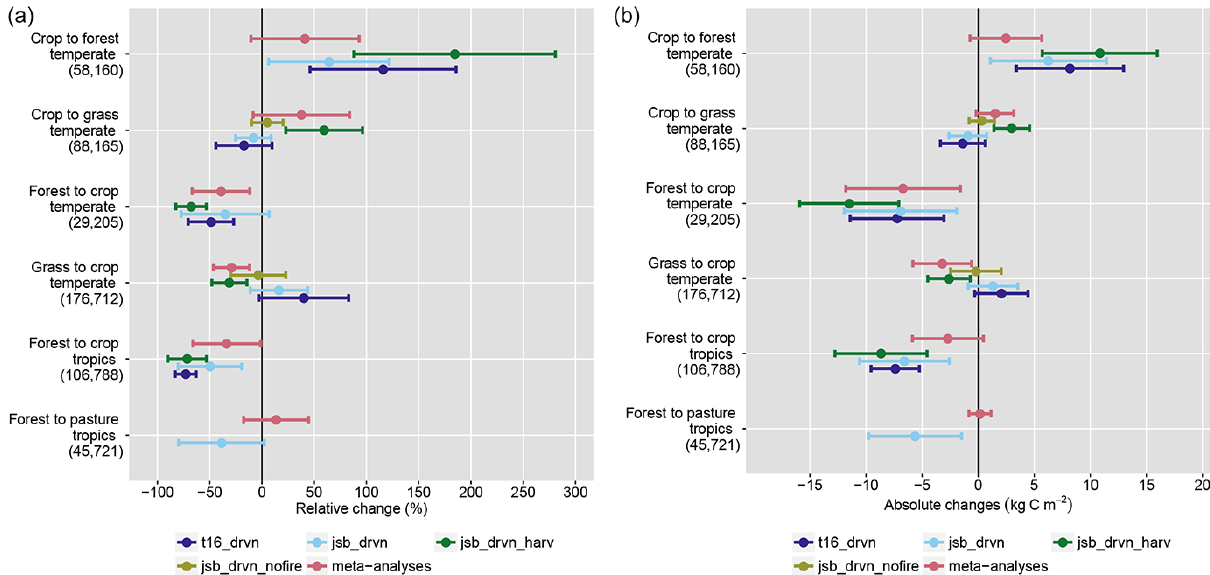
Figure 1. Mean simulated equilibrium relative (a) and absolute changes in soil carbon (b) compared to results from the meta-analyses. The first number in the parenthesis represents the number of studies in the meta-analyses and the second is the number of grid cells from the global simulation that fulfill the climate criterion in the meta-analyses (regions in Fig. S1). The dots represent the mean changes, and the bars represent the standard deviation.